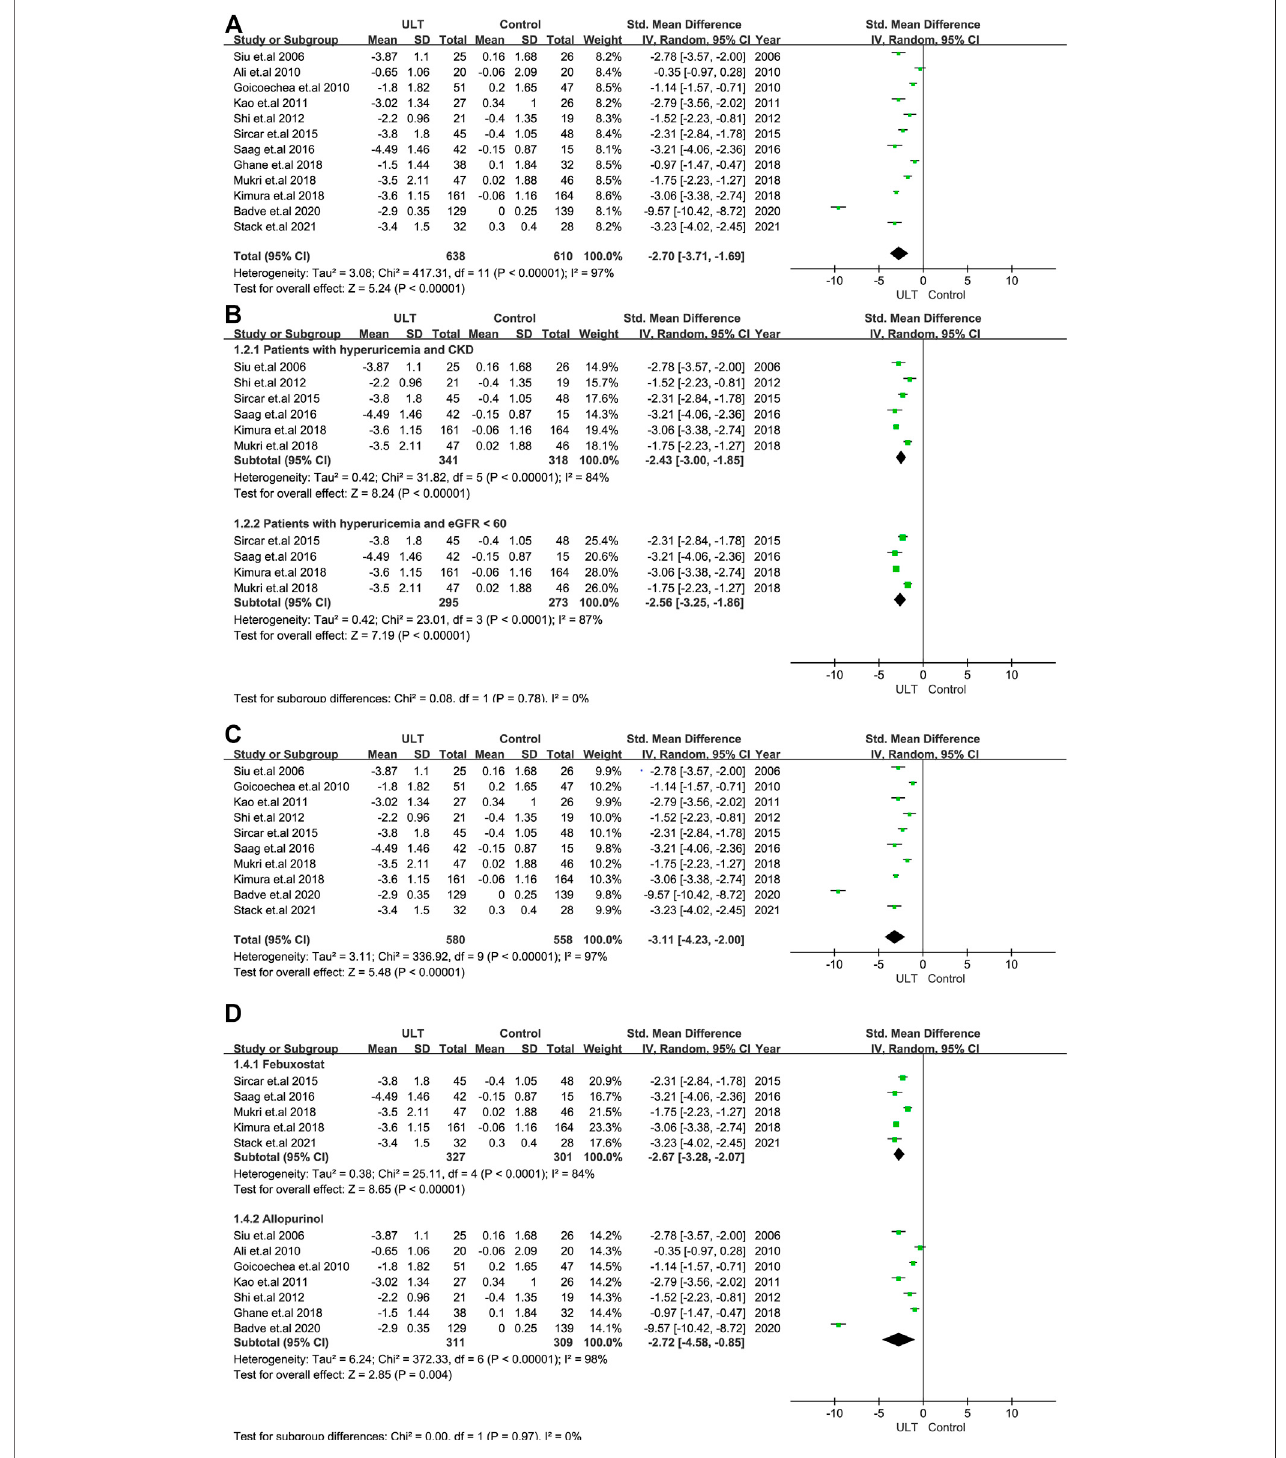
FIGURE 2 | The effect of ULT compared with the control on SUA. (A) All patients. (B) Subgroup analysis of patients with hyperuricemia and CKD or patients with hyperuricemia and eGFR < 60 ml/min/1.73 m 2 . (C) Subgroup analysis including patients with a treatment duration of 6 months or over. (D) Subgroup analysis for ULT drugs including febuxostat and allopurinol. Abbreviations: SMD, standard mean difference; CI, con fi dence interval; eGFR, estimated glomerular fi ltration rate.